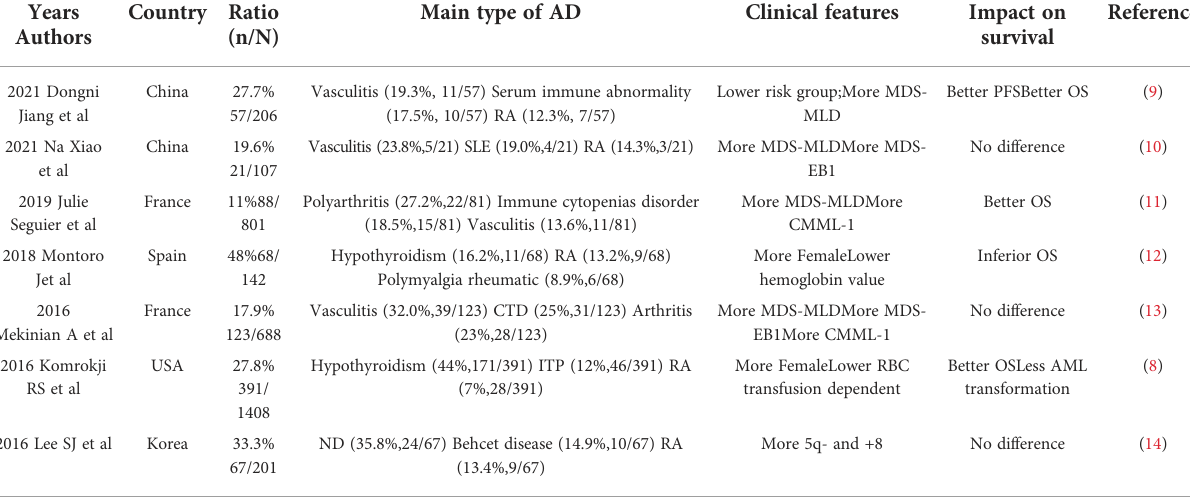
TABLE 1 The studies evaluated the frequency and characteristics of MDS patients with AD in the last 5 years.